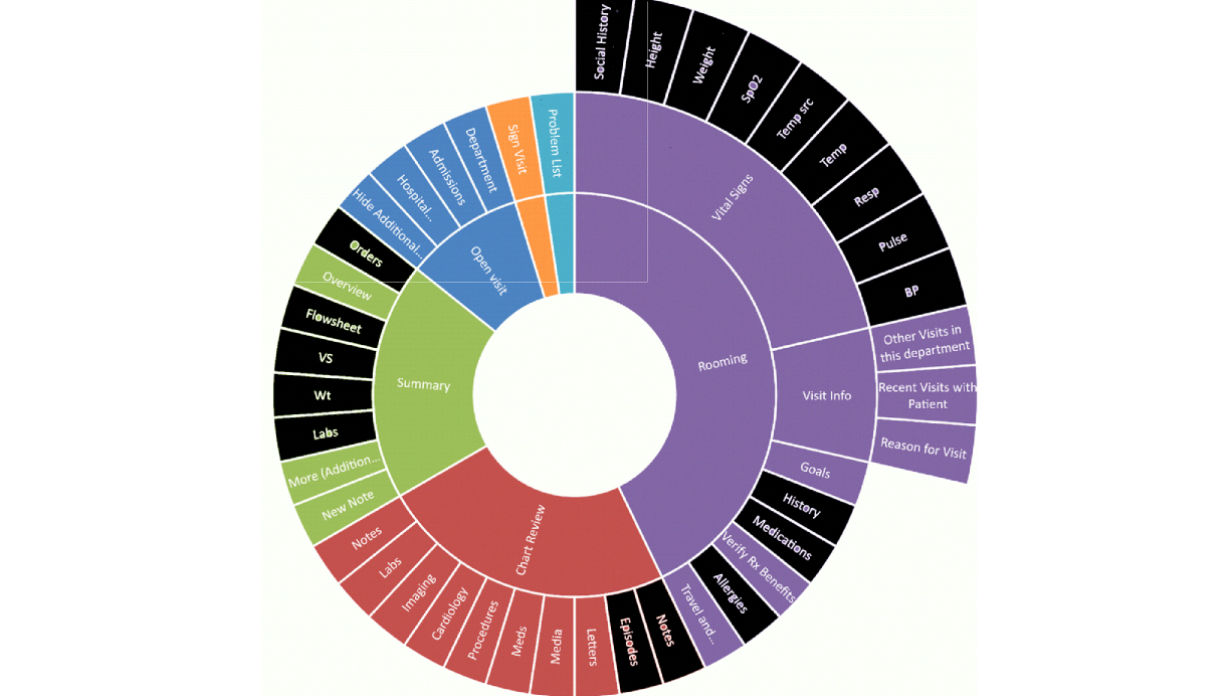
Figure 6. Sunburst diagram representing display fragmentation of clinical data in a second conventional, commercial electronic health record. Elements colored in black are those relevant for handling the clinical problem (general review of patient information). EHR: electronic health record.